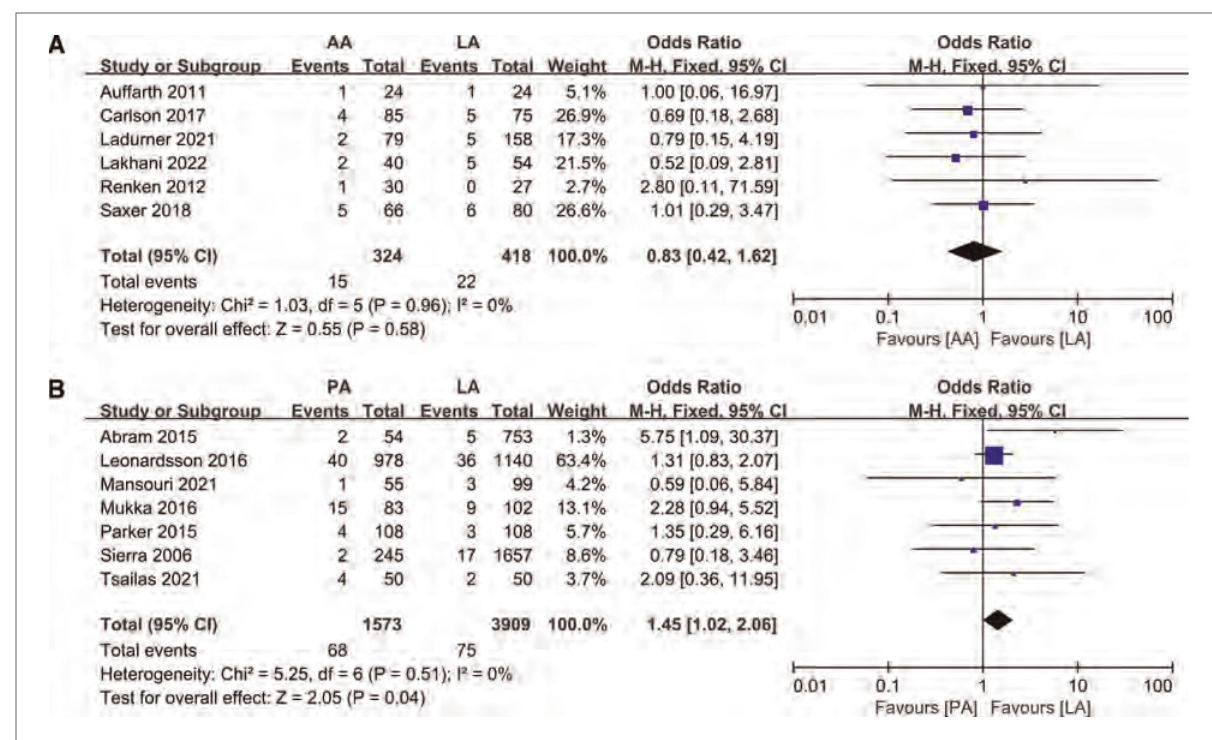
FIGURE 9 Forest plot comparison of reoperation. ( A ) Anterior approach and lateral approach, ( B ) Posterior approach and lateral